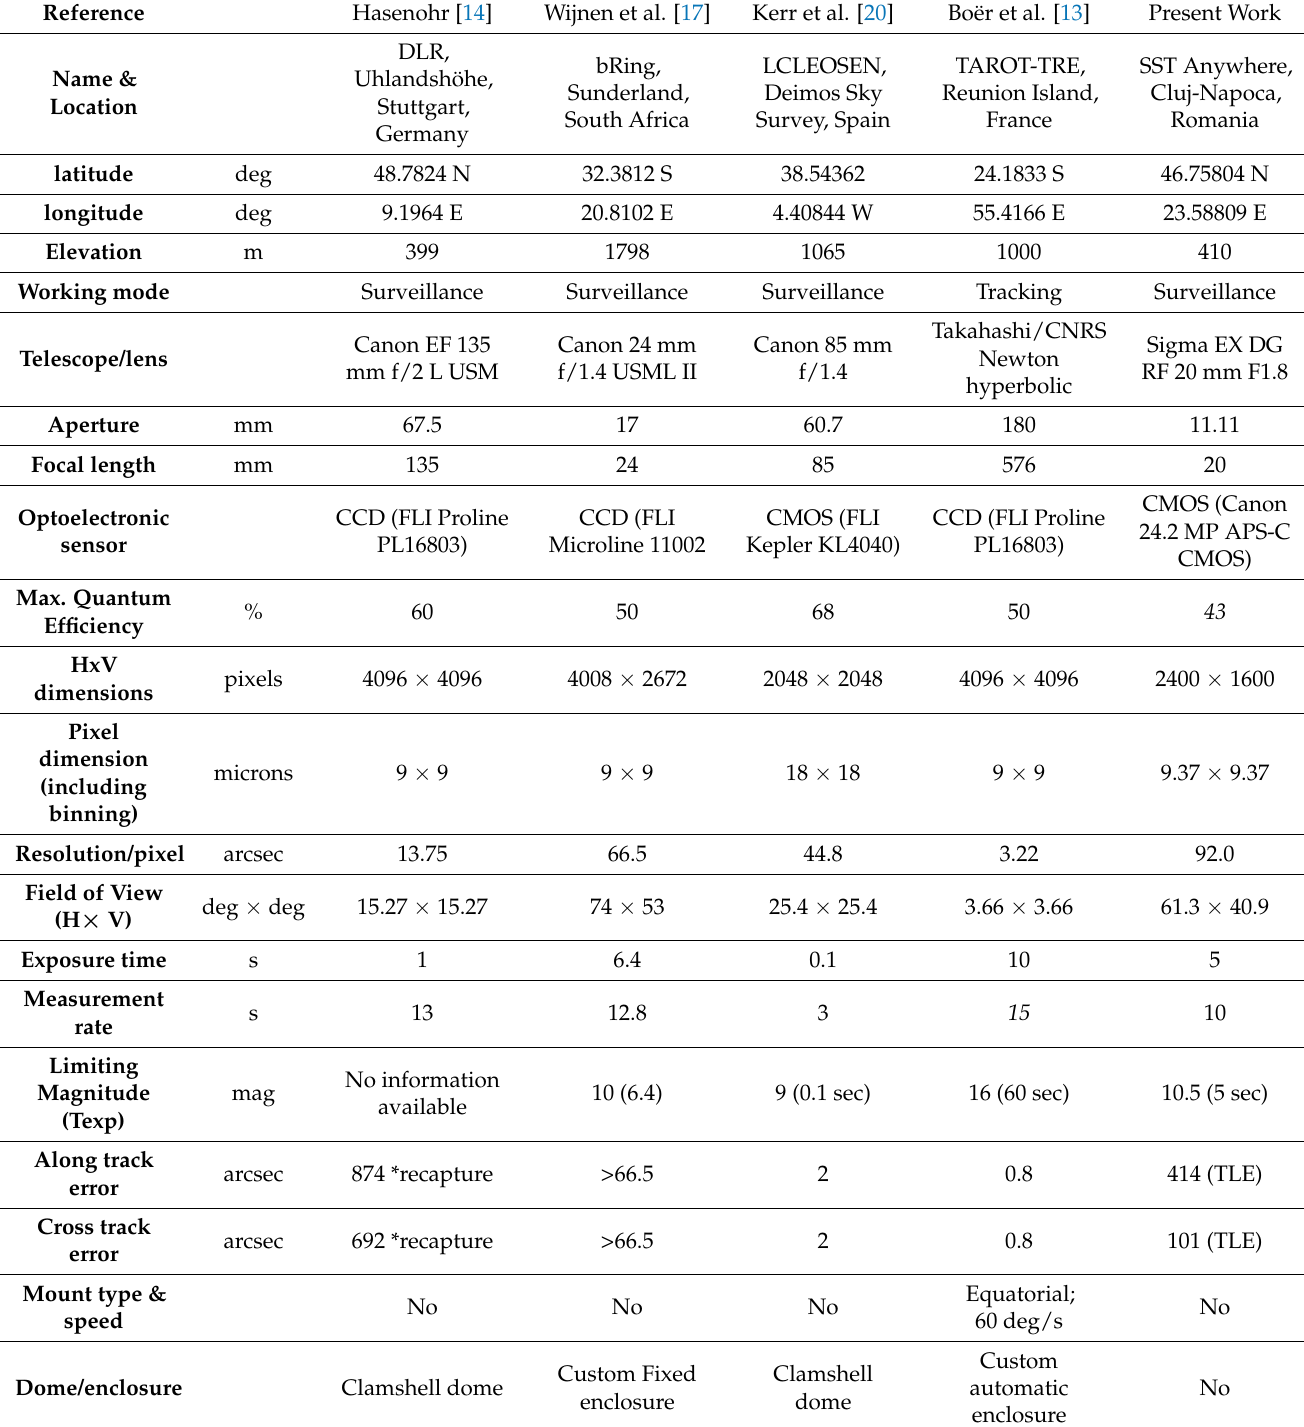
Table 4. Comparison of the main characteristics of similar LEO optical surveillance